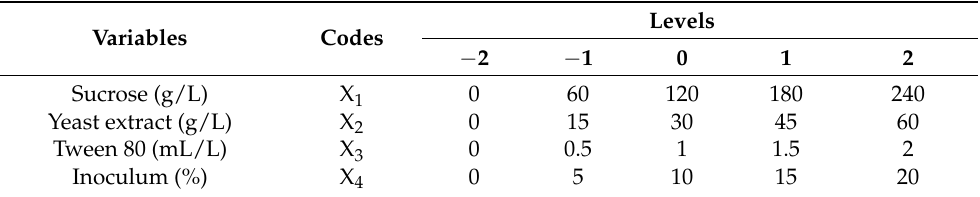
Table 2. Real values of coded independent